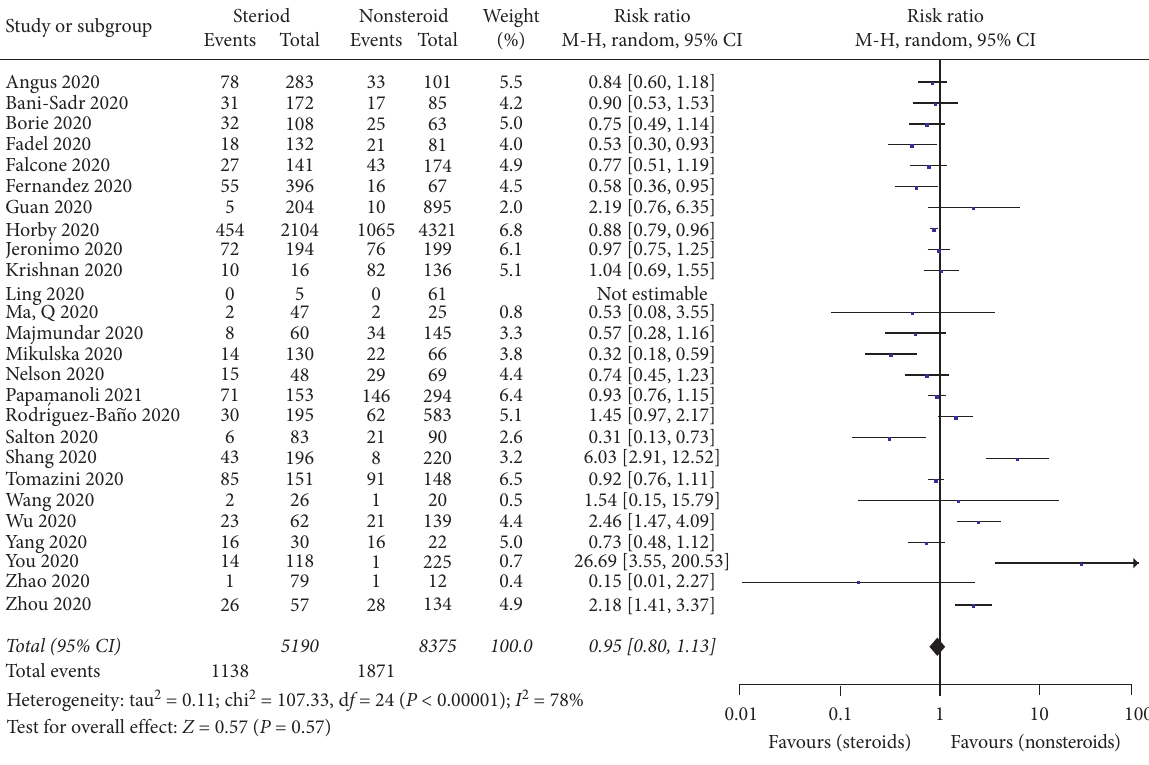
Figure 2: Forest plot for mortality of COVID-19 patients taking steroids versus nonsteroids.